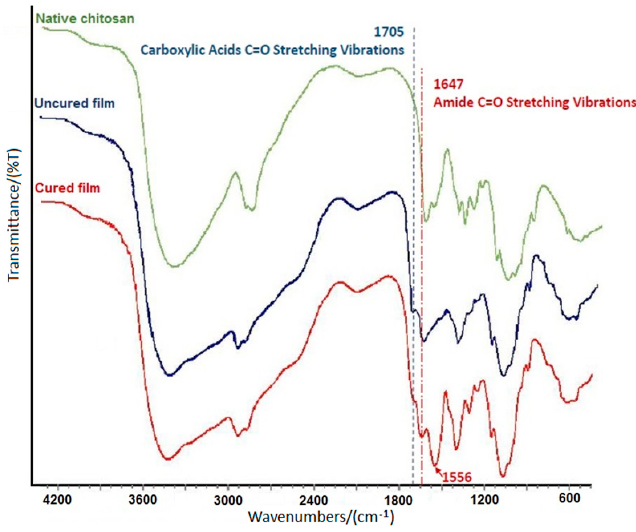
Figure 1. Fourier transform infrared (FT-IR) spectra of native chitosan, uncured chitosan-adipic acid film, and chitosan-adipic acid cured film at 90 °C for 60 min.